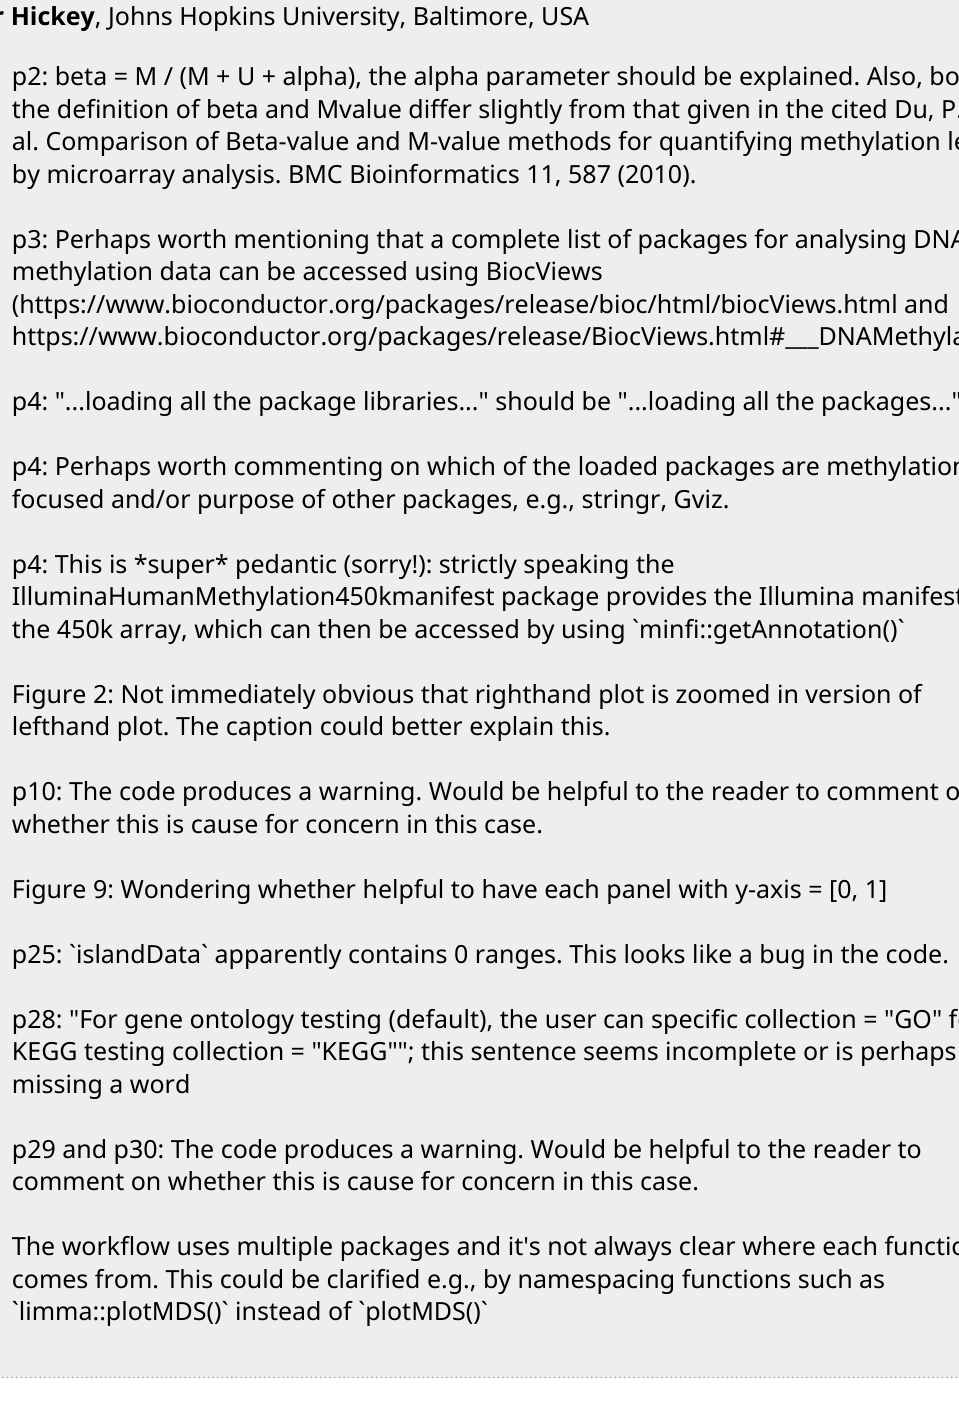
Figure 9: Wondering whether helpful to have each panel with y-axis = [0, 1]